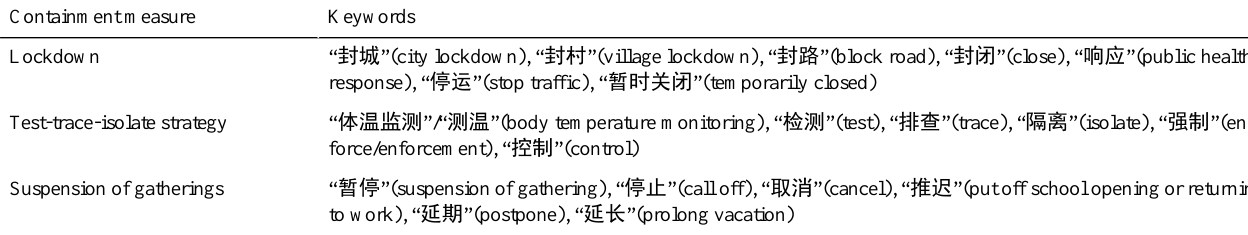
Table 1. Keywords related to containment measures associated with the COVID-19